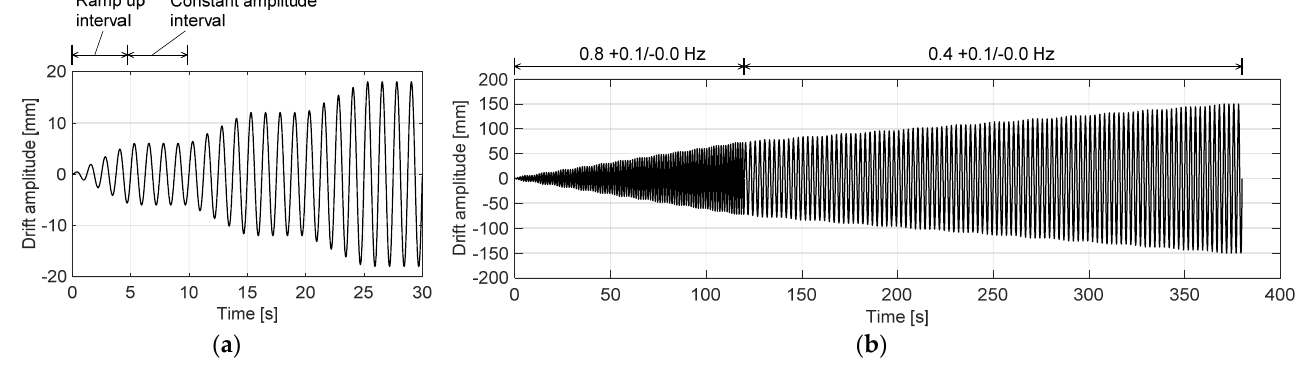
Figure 9. Drift time history for dynamic crescendo test: ( a ) first 30 s and ( b ) full time history (AAMA